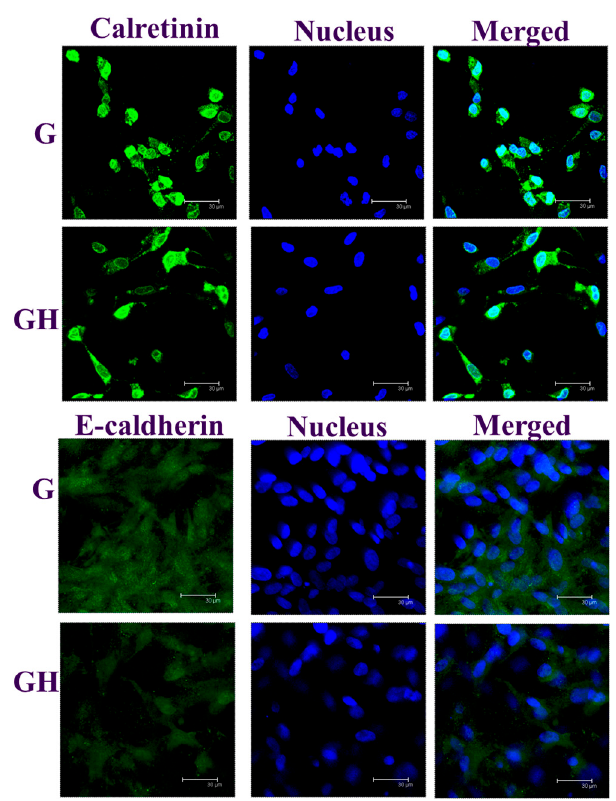
Figure 7. The immunofluorescence (IF) staining of calretinin and E-cadherin of the mesothelial cells cultured in G and GH for seven days. The protein was stained green by a fluorescein isothiocyanate (FITC)-conjugated secondary antibody, while the nuclei were stained blue by Hoechst 33342. Bar = 30 μ m.